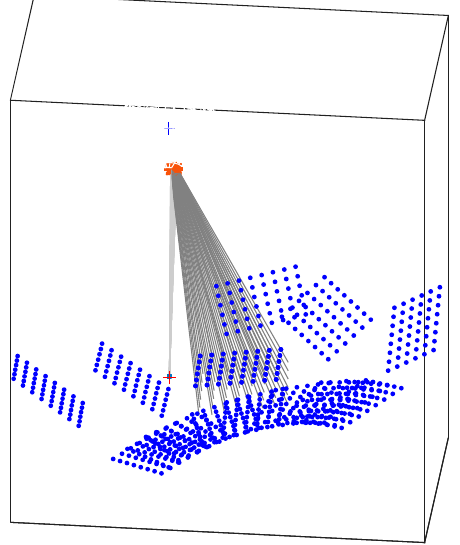
Figure 8. Optimized poses of the acquired grids.